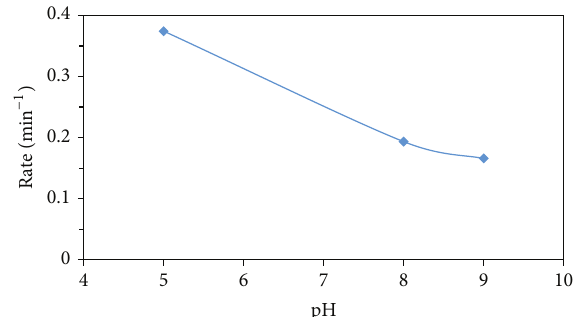
Figure 3: Effect of pH on the photocatalytic degradation of mixture of Ar 1254 (0.5 ppm) and Ar 1260 (0.5 ppm) in seawater using 0.5 g L −1 of CM-n-TiO 2 under illumination of UV